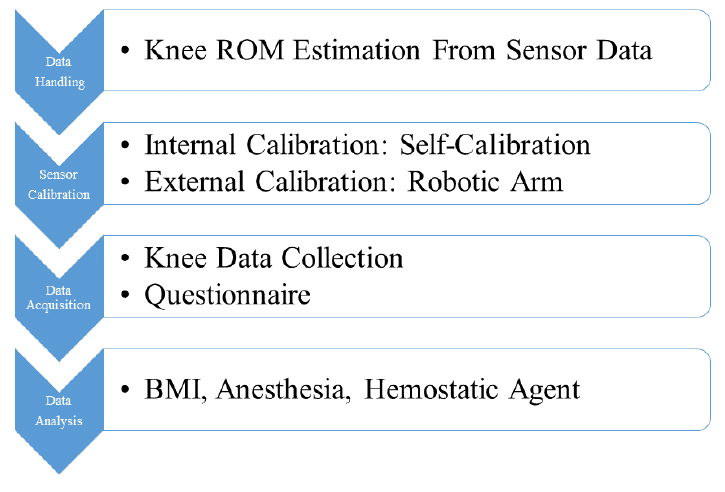
Figure 1. The workflow and tasks of this study.